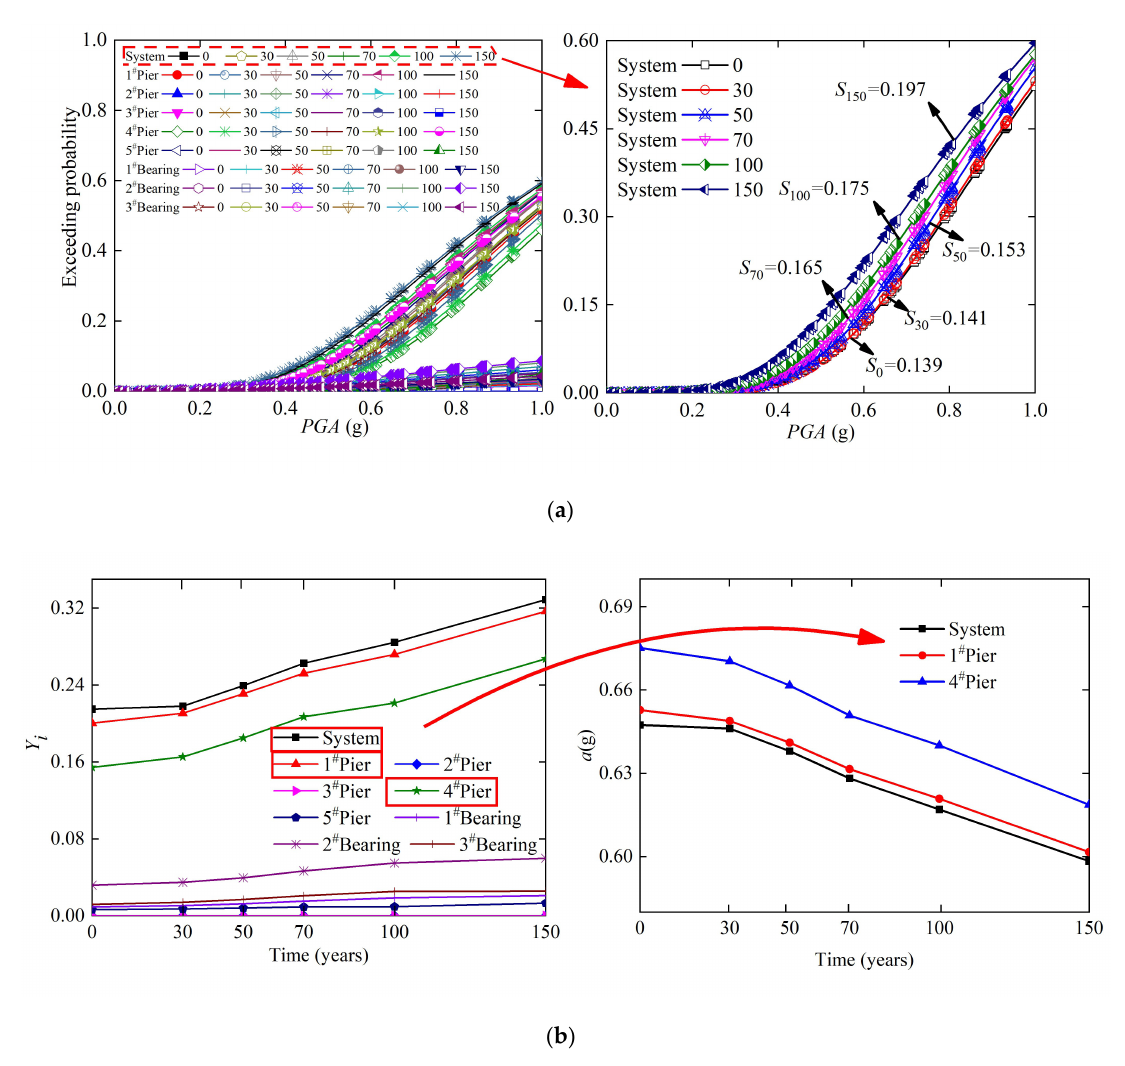
Figure 12. Fragility analysis in (working condition) WC1: ( a ) Time-variant fragility curve of each component and bridge system; ( b ) Time-variant fragility coe ffi cient of components and bridge